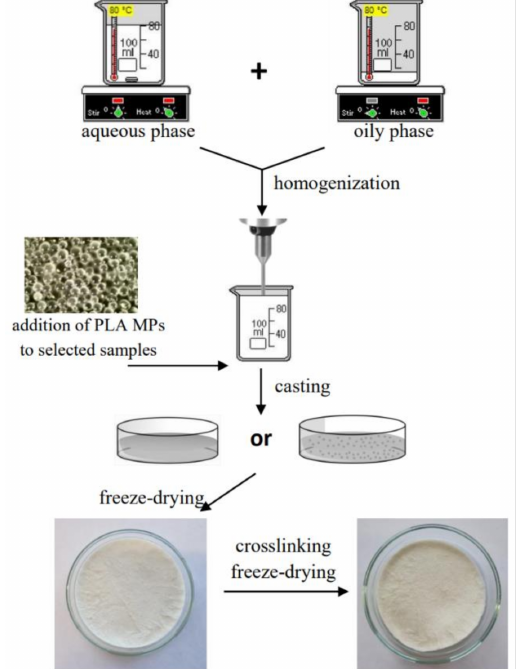
Figure 1. The scheme of preparation of freeze-dried emulsion matrices. Adapted from